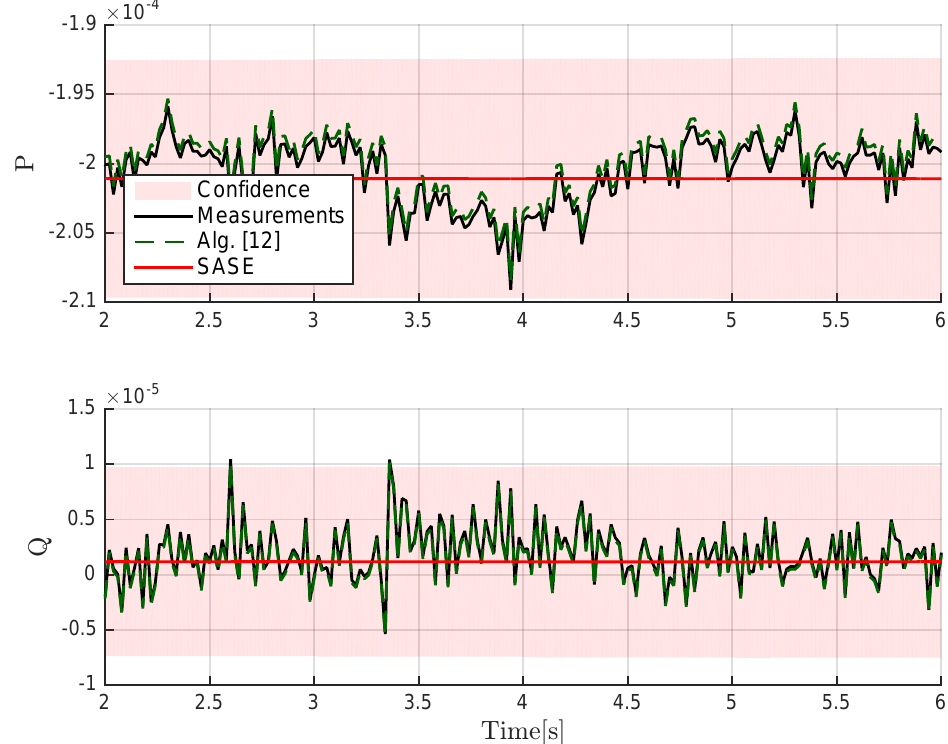
Figure 7. Evolution of the estimates at node 3 (used for estimation) using three PMUs for estimation and two for